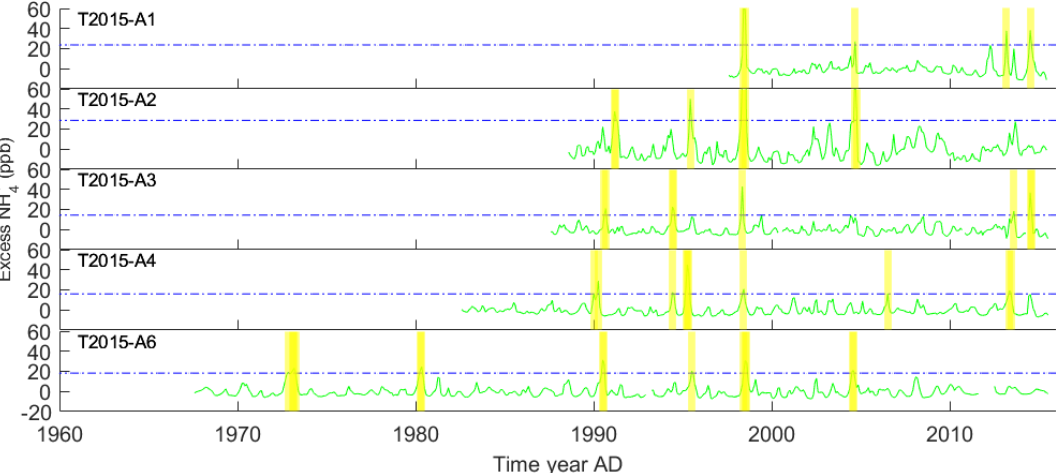
+ (green) as compared to a 5-year running average. Vertical bars (yellow) indicate times exceeding the 97.5% quantile Figure 7. Excess NH 4 (horizontal blue dashed). T2015-A1 through T2015-A6 are shown from top to bottom; note that T2015-A5 was not analyzed for NH +